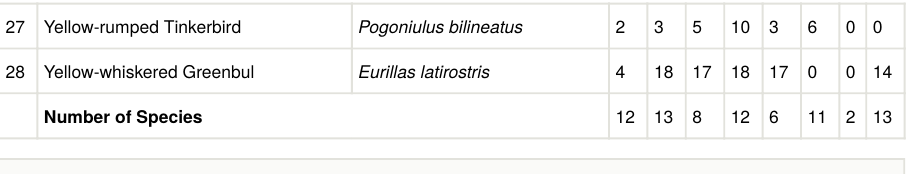
Table 8. Spatial distribution of species in both foreground and background recordings. The number of recordings per location for each of the species is